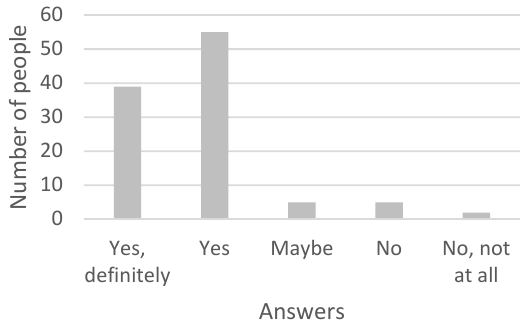
Figure A13. Opinion on usefulness of relatable information on recycling, first survey (106 individuals).